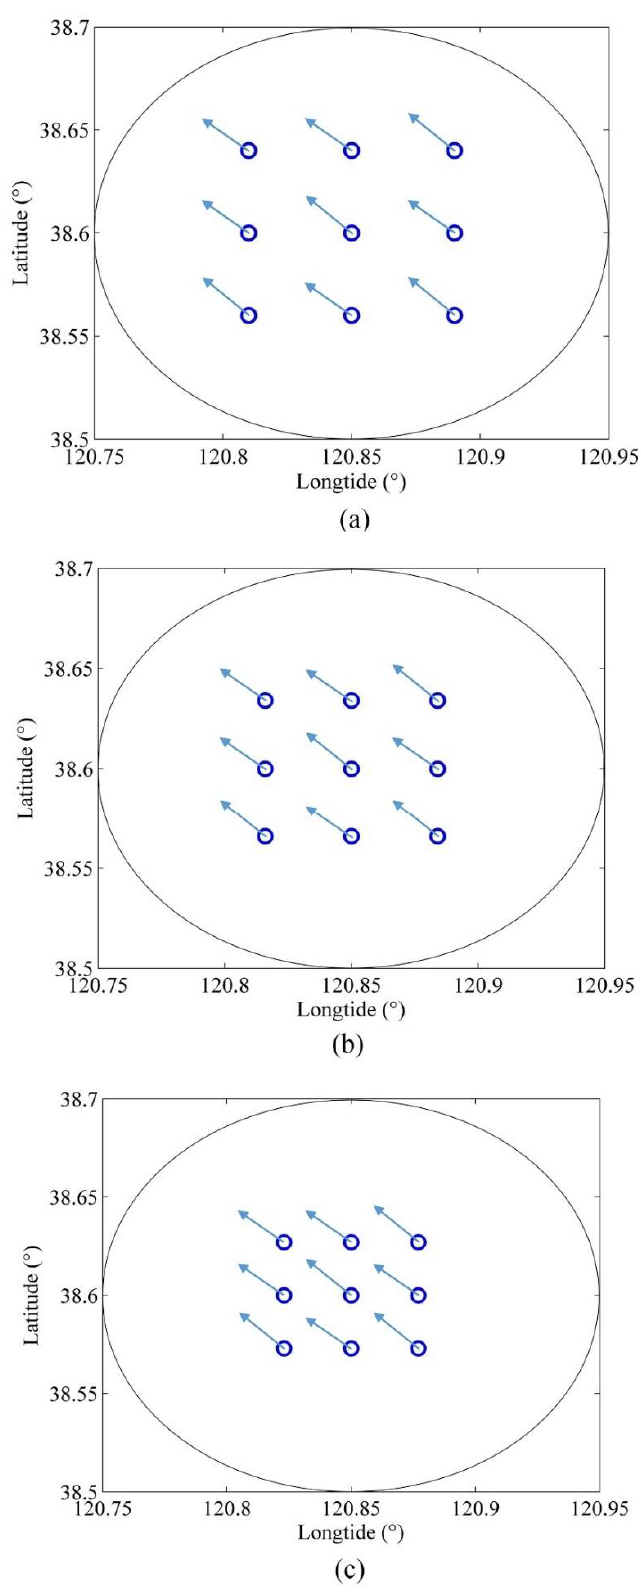
Figure 8. The three scenarios for the second simulated case study ( a ) Scenario 1; ( b ) Scenario 2; ( c ) Scenario 3.